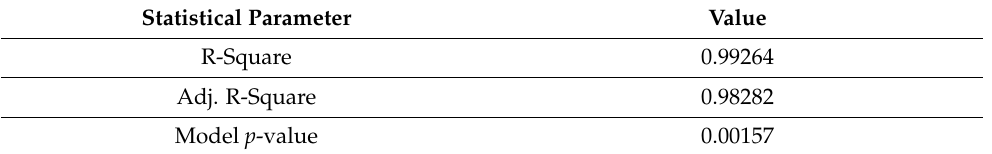
Table 4. Summary table ANOVA.